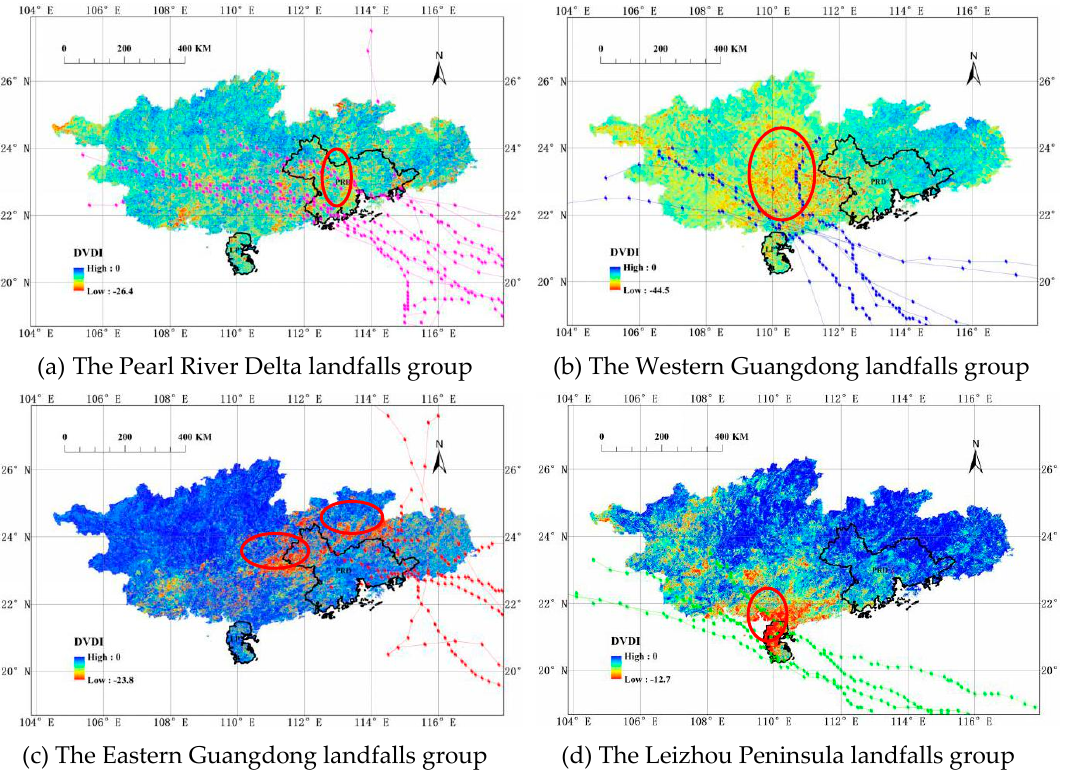
Figure 6. The spatial distributions of accumulated DVDIs of four groups: ( a ) The Pearl River Delta landfalls group; ( b ) The Western Guangdong landfalls group; ( c ) The Eastern Guangdong landfalls group; ( d ) The Leizhou Peninsula landfalls group.